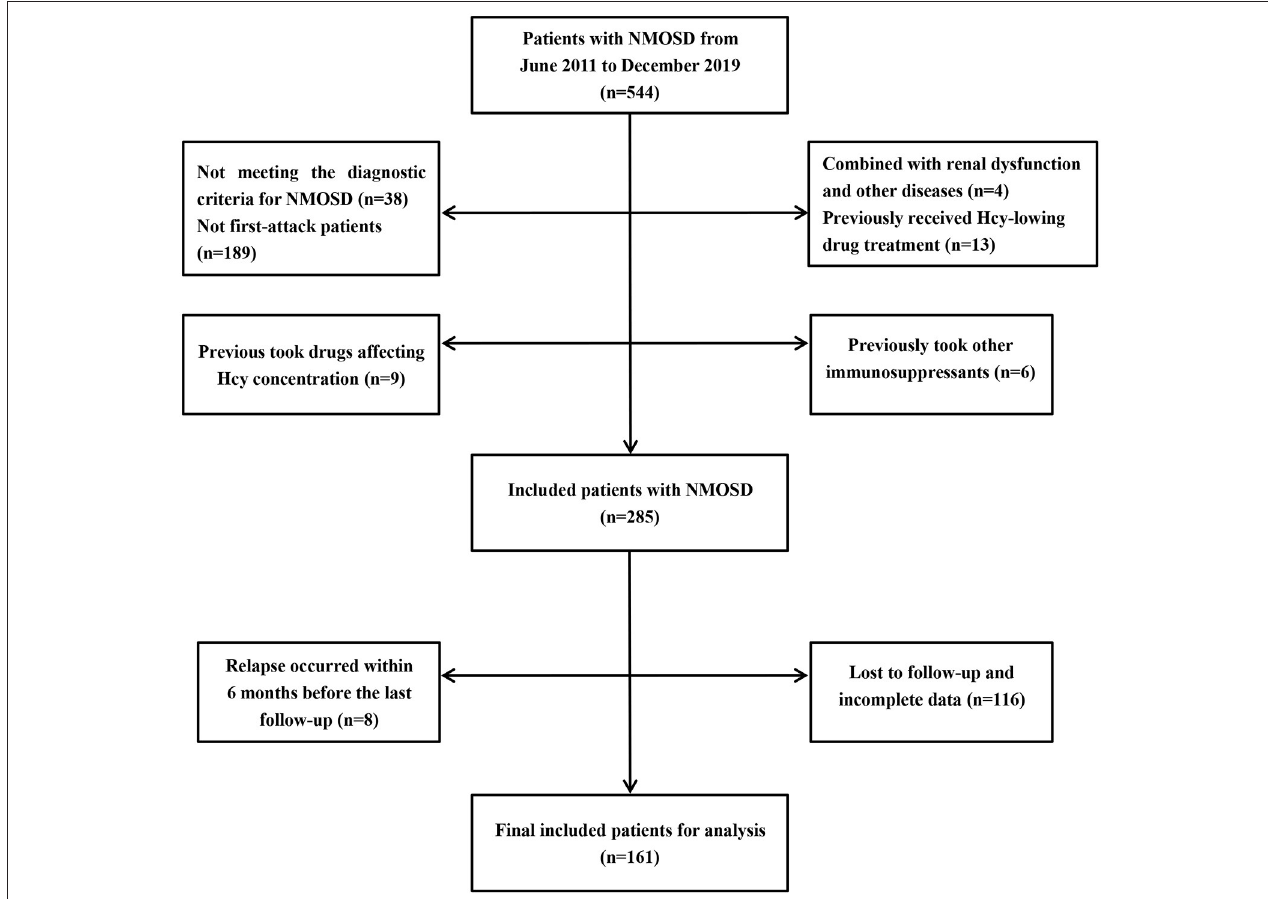
FIGURE 1 | Patients selection process. NMOSD, neuromyelitis optica spectrum disorders; Hcy,